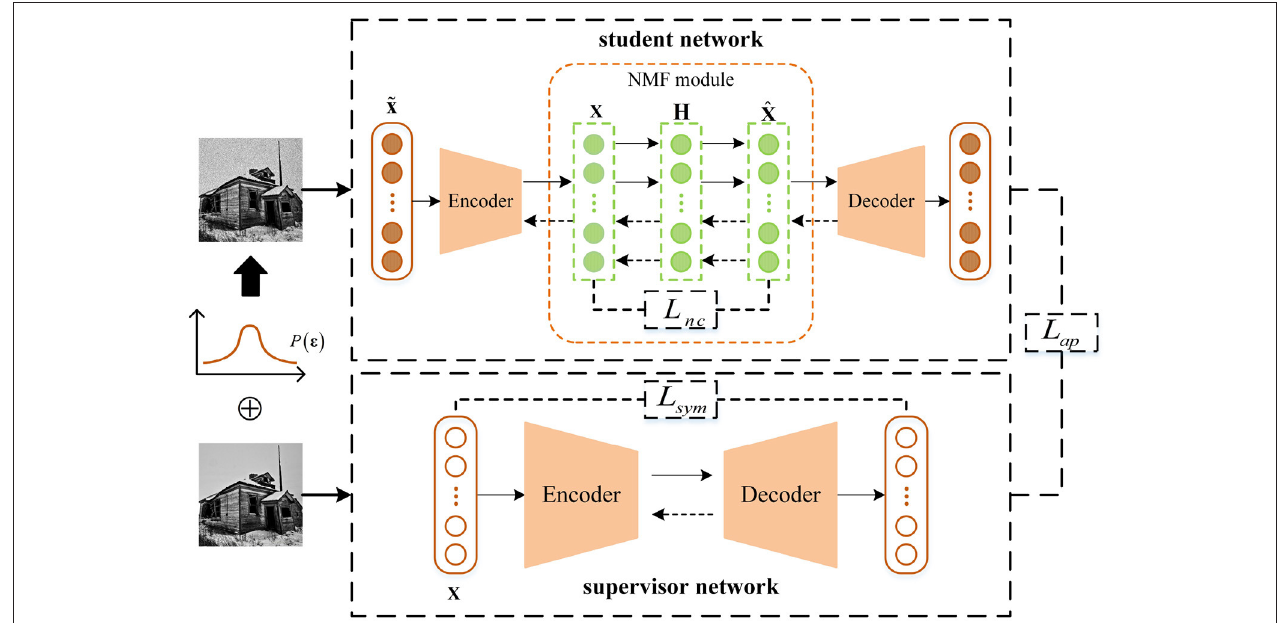
FIGURE 1 | The architecture of